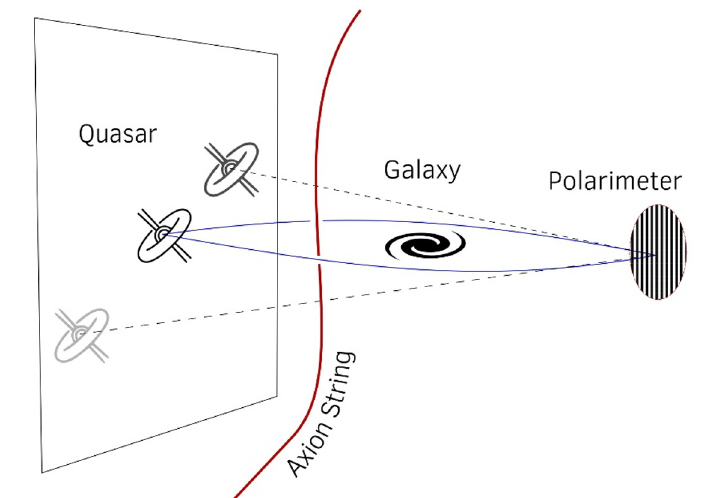
Figure 8 . A quasar at a cosmological distance is gravitationally lensed by a galaxy or galaxy cluster in between the quasar and the observer. The di(cid:11)erent photon trajectories (blue lines) from the quasar to the observer, corresponding to di(cid:11)erent quasar images, form a closed loop around the gravitational lens. An axion string (red line) can pass through this closed loop of photon trajectories, leading to a di(cid:11)erential polarization rotation angle between the two photon trajectories (quasar